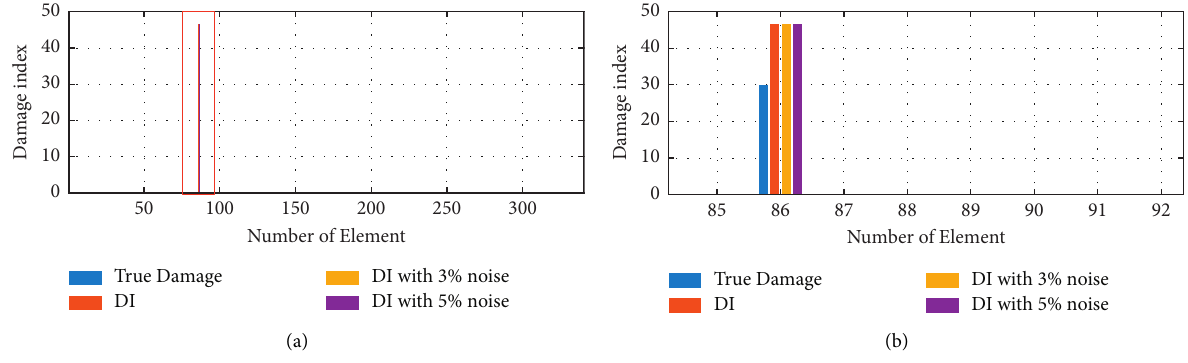
Figure 13: Results of single-damage scenario D2 containing measurement noise. (a) Original result. (b) Zoomed result.